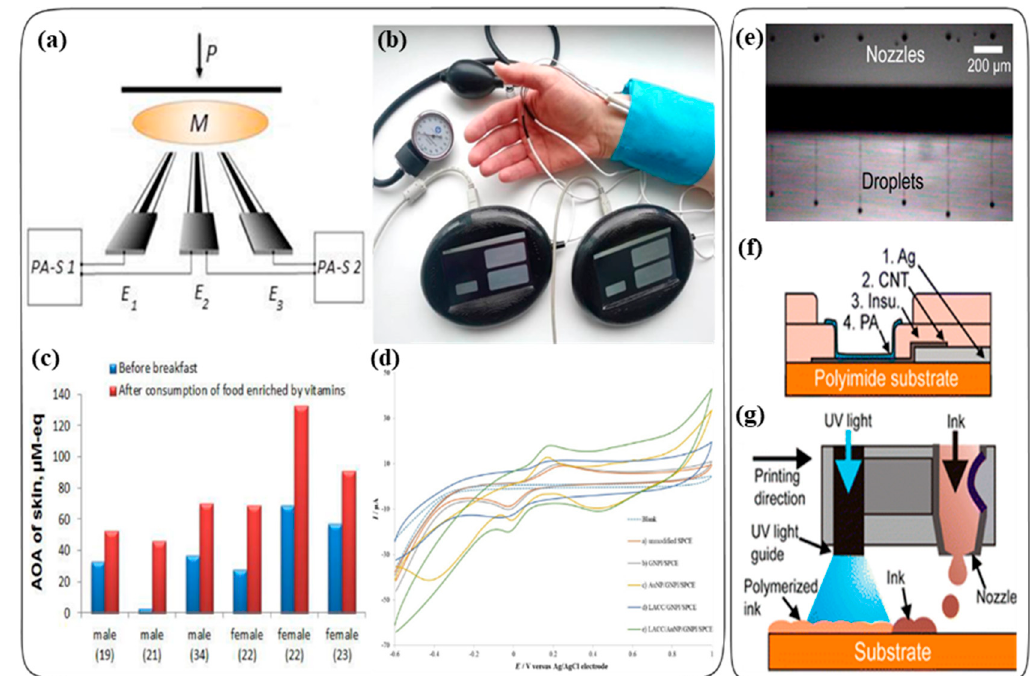
Figure 3. ( a ) Measuring scheme. ( b ) Photo illustrating the monitoring process of skin